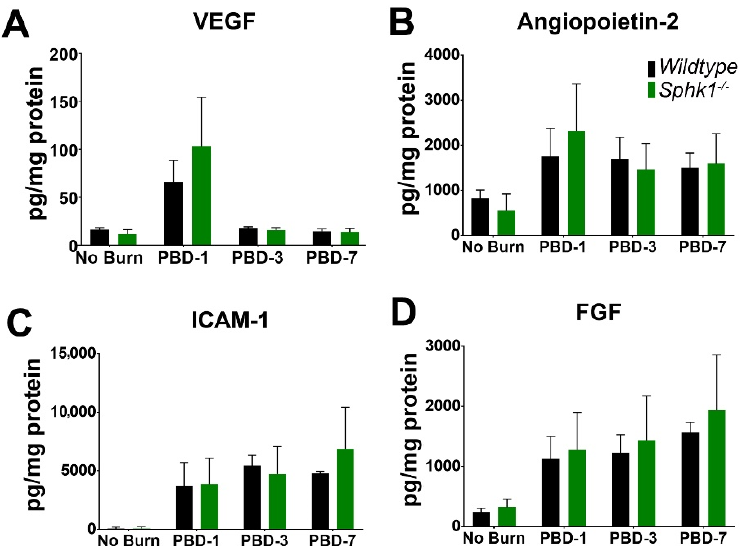
Figure 5. Angiogenic and fibrotic markers are altered in the cornea following alkali burn. WT and Sphk1 − / − mice corneas ( n = 3) were harvested 1, 3, and 7 days post alkali burn, along with unburned controls, and the levels of angiogenic and fibrotic markers VEGF ( A ), Angiopoitin-2 ( B ), ICAM-1 ( C ) and FGF ( D ) were measured by Luminex assay (Values are mean ± SD).